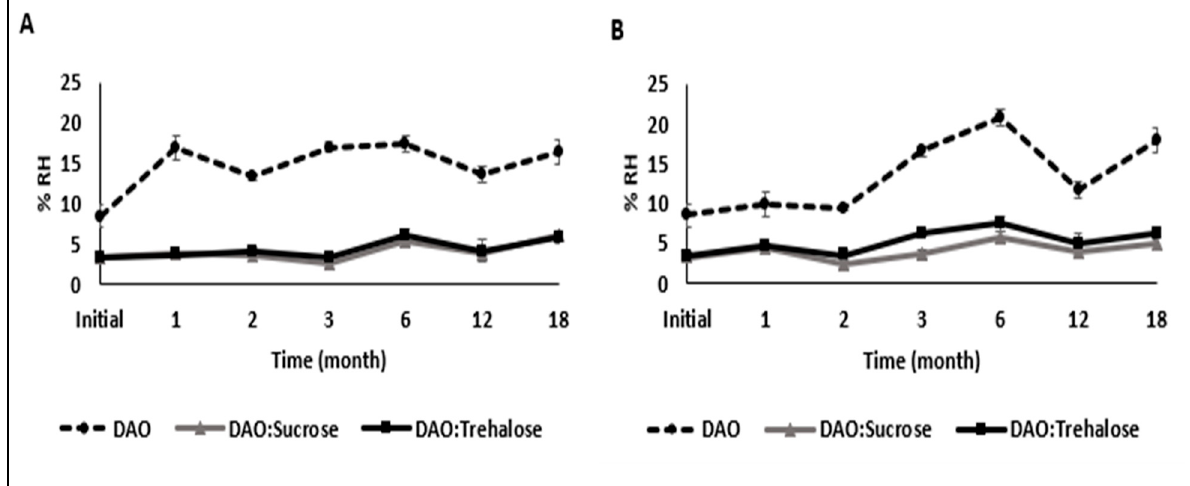
Figure 3. Time course of the residual humidity of vDAO powder formulations stored at different temperatures: ( A ) at 4 °C; ( B ) at − 20 °C. The reported values are the mean ± standard deviation (SD); temperatures: ( A ) at 4 ◦ C; ( B ) at − 20 ◦ C. The reported values are the mean ± standard deviation n = 3 different experiments. (SD); n = 3 different